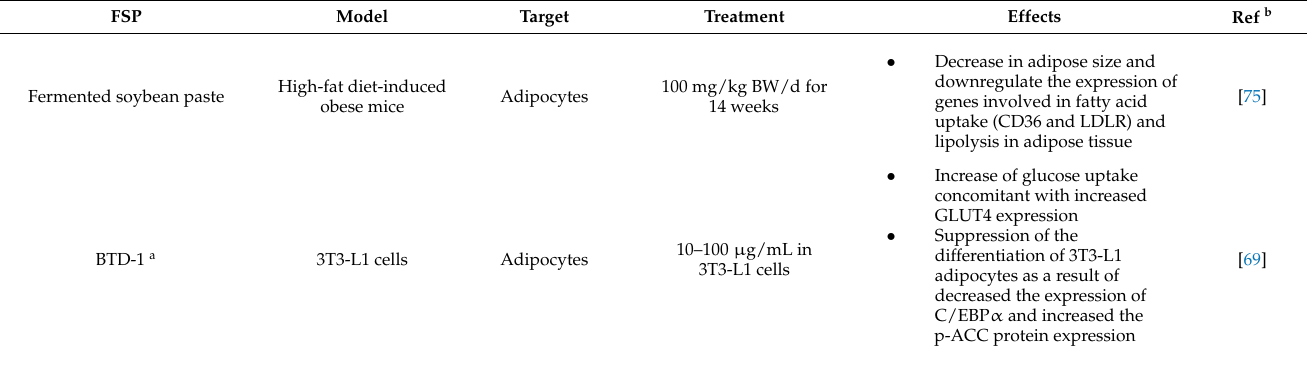
Table 5. The mechanisms of modulating the effect of FSP on glucose homeostasis in adipose